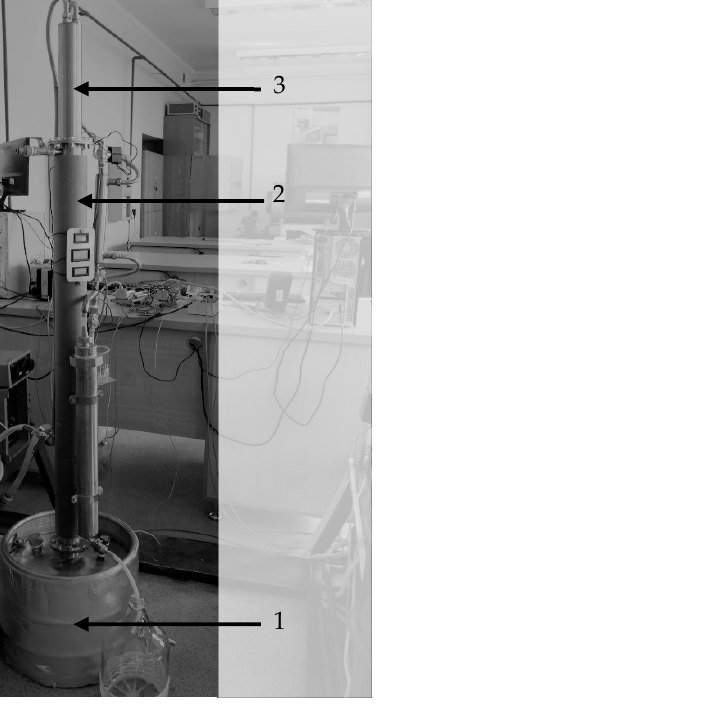
Figure 2. Rectification column: 1—reservoir with heating coil, 2—dephlegmator and 3—cooling head.